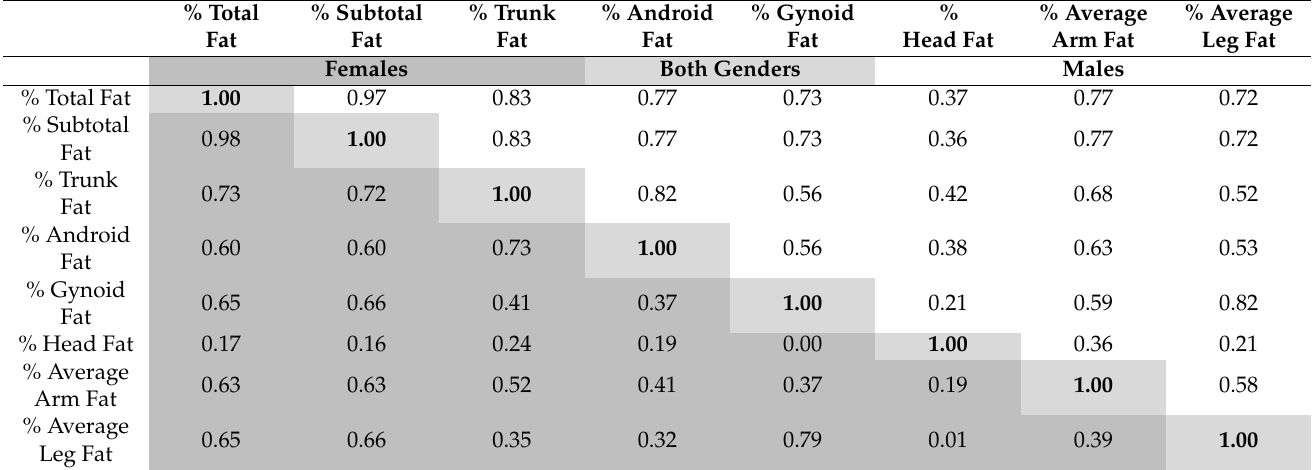
Table 4. Correlations between Regional Body Fat Measures in Obese Males and Females.